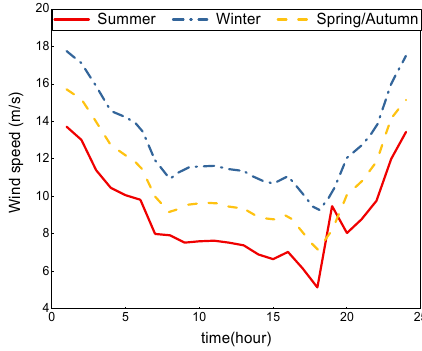
Figure 9. Wind speed at 24 h a day in different seasons.